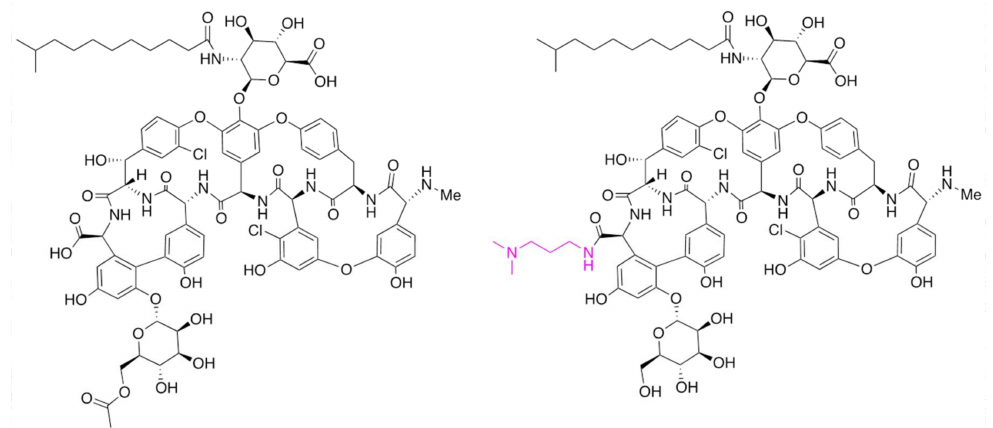
Figure 1. Chemical structures of O -acetyl A40926 and of dalbavancin. Only the component B0 is shown for simplicity. The chemical modification present in dalbavancin is indicated in red